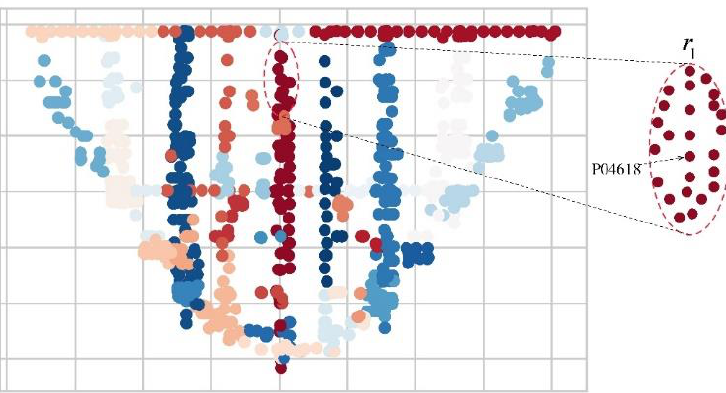
Figure 7. All local regions and local region r 1 . Table 1. Dam safety monitoring dataset descriptions.